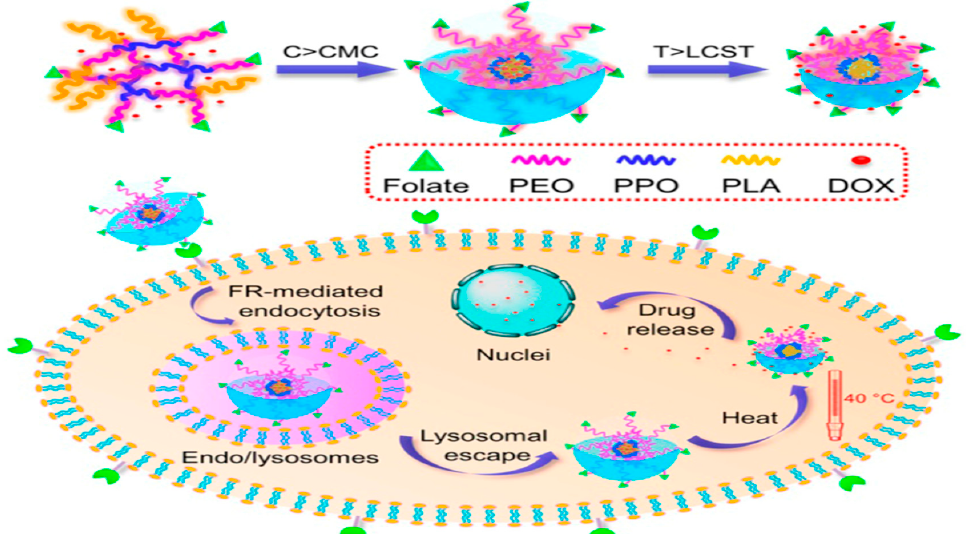
Figure 7. Scheme of temperature-responsive micelle formation progresses in the tumor tissue re- sponsive to temperature. Reprinted with permission from Ref. [66]. Copyright 2014, Zhou, S.